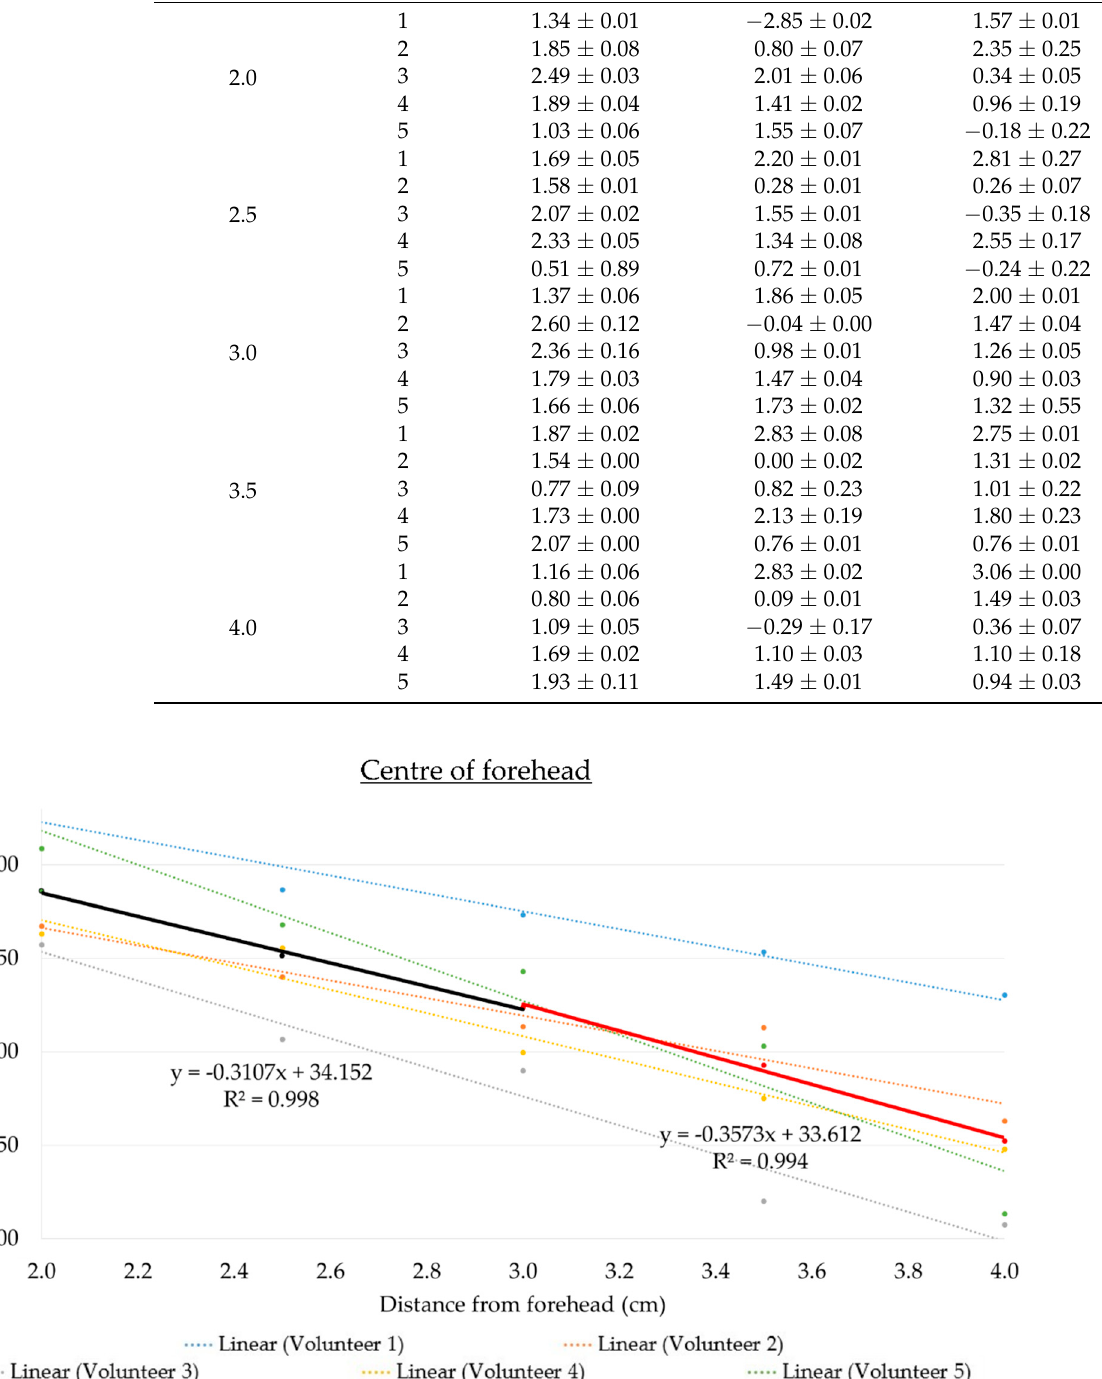
Table 2. Difference between the dry and wet forehead temperatures on the respective locations from 2–4 cm. The positive value implies that the dry forehead registers a higher temperature. Difference between the Dry and Wet (Dry-Wet) Forehead ( ◦ C) Distance (cm) Volunteer